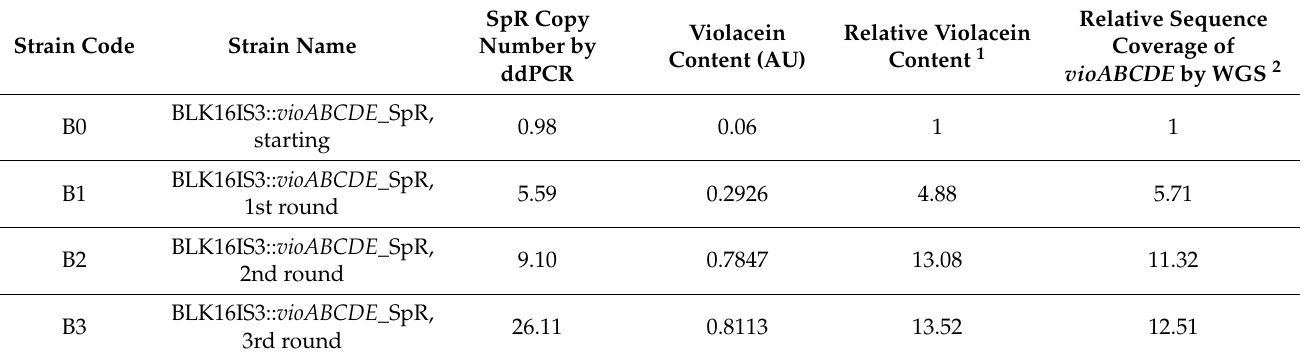
Table 4. Properties of E. coli BLK16IS 3 :: vioABCDE _SpR derivatives after the indicated rounds of IS3 transposase induction.